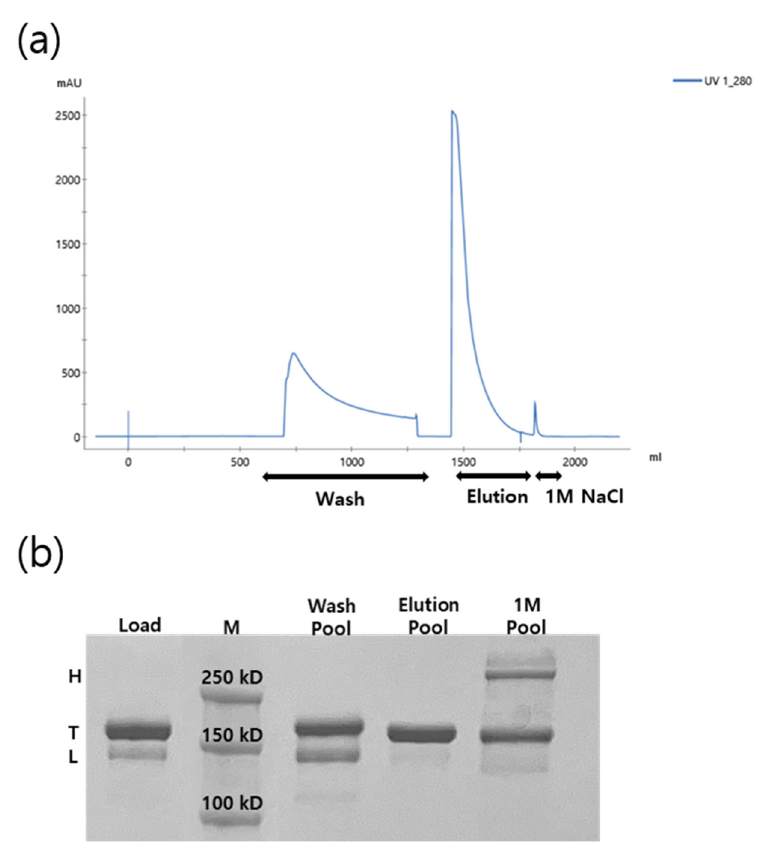
Figure 8. Chromatogram and SDS-PAGE results of the verification run ( a , b ). Band H: HMW proteins; band T: target protein; band L: LMW proteins. The column used Fractogel ® EMD SO 3 − (M) resin in a 2.6 cm × 15 cm column at a flow rate of 200 cm/h.